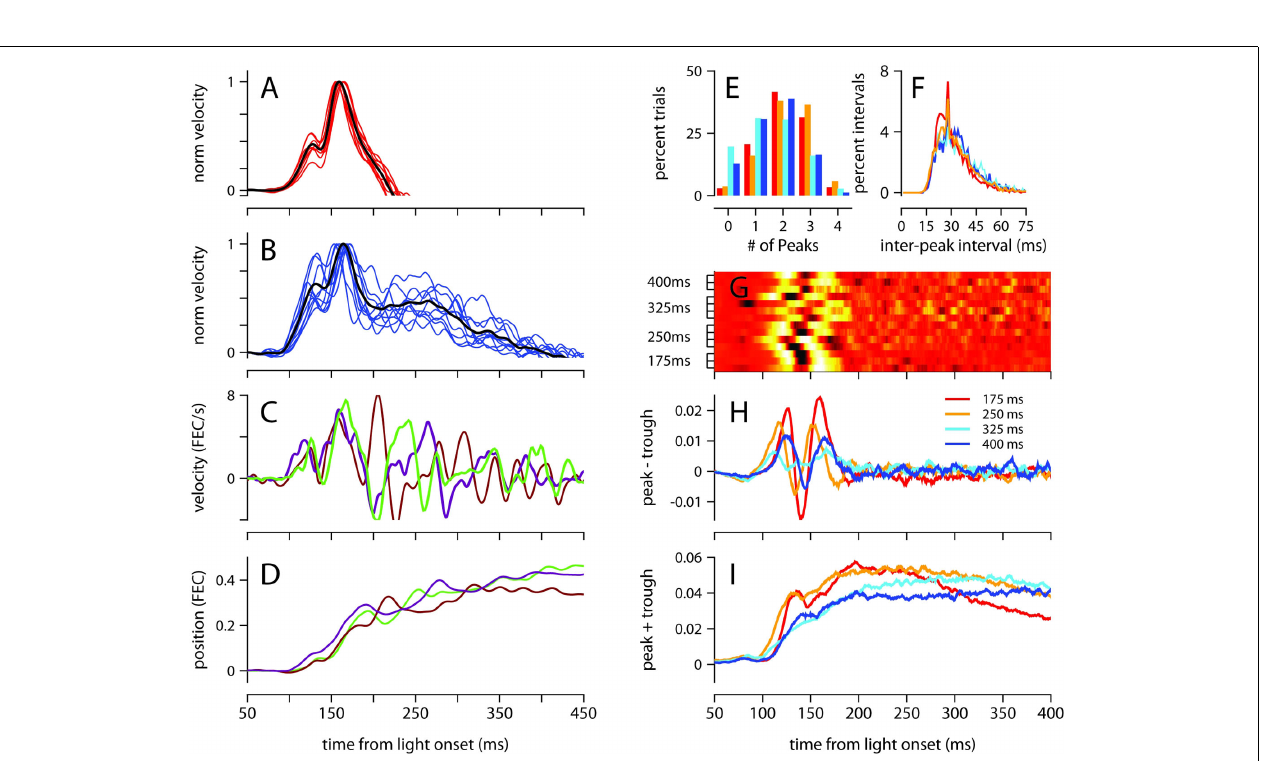
FIGURE 2 |Temporal profile of the conditioned eyelid movement in individual mice. (A) Normalized average position, and (B) normalized average velocity, of each mouse’s conditioned eyelid responses. Color code indicates trained ISI and is shown in (B) . (C) Probability density functions for latency to